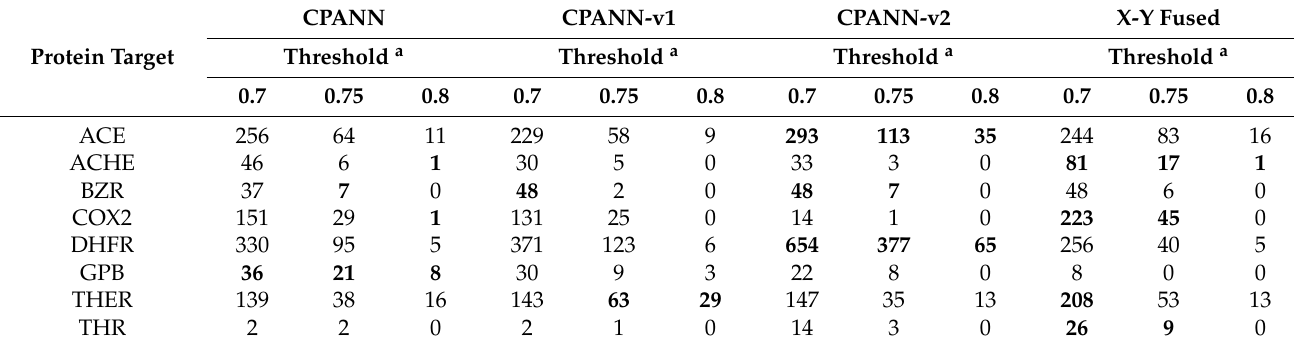
Table 5. Number of selected models obtained for the additional